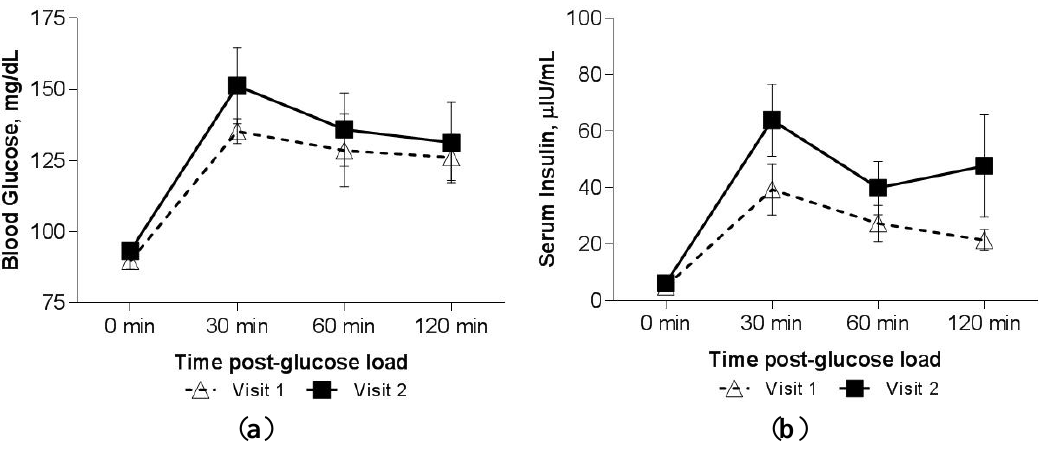
Figure 3. ( a ) Blood glucose response to a 75-g oral glucose load in n = 5 patients with Thalassemia who had a decline in serum zinc, measured at two separate visits, two years apart. Values above are mean blood glucose ± SEM. ( b ) Serum insulin response to a 75-g oral glucose load in n = 5 patients with Thalassemia who had a decline in serum zinc, measured at two separate visits, two years apart. Insulin values above are raw means ±